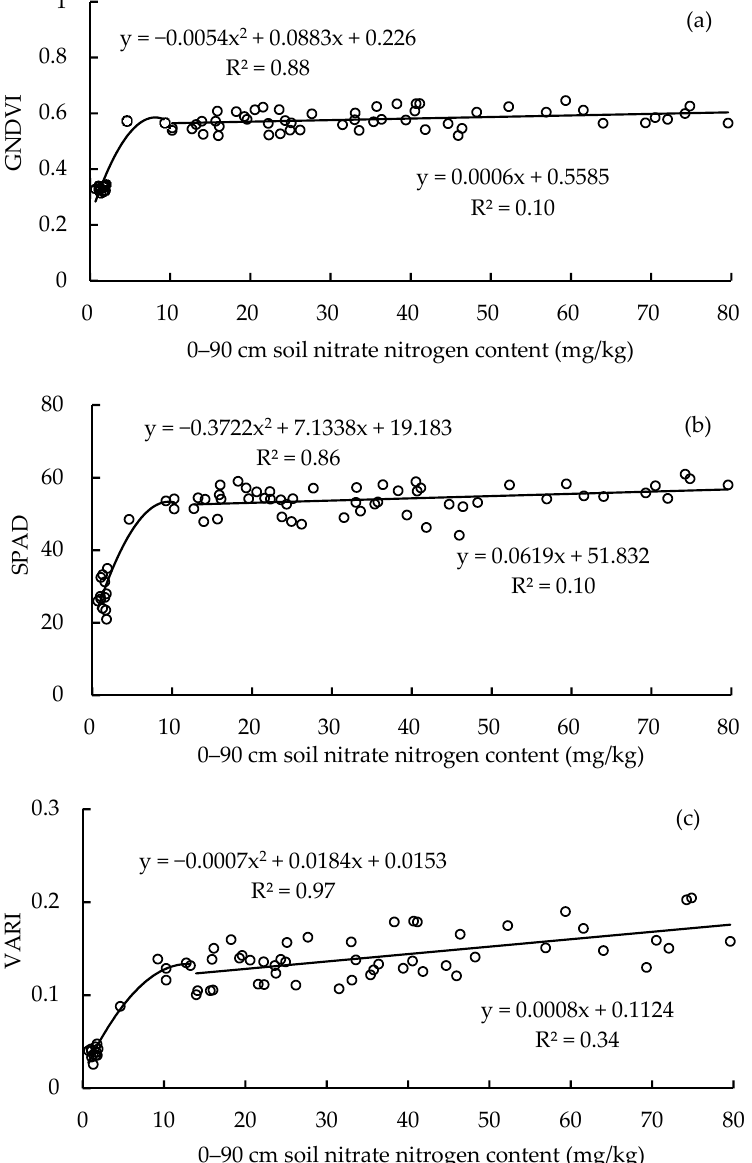
Figure 7. Analyses of the saturation response of GNDVI, SPAD, and VARI. ( a – c ) Show the saturation response for the method of GNDVI, SPAD, and VARI, respectively.